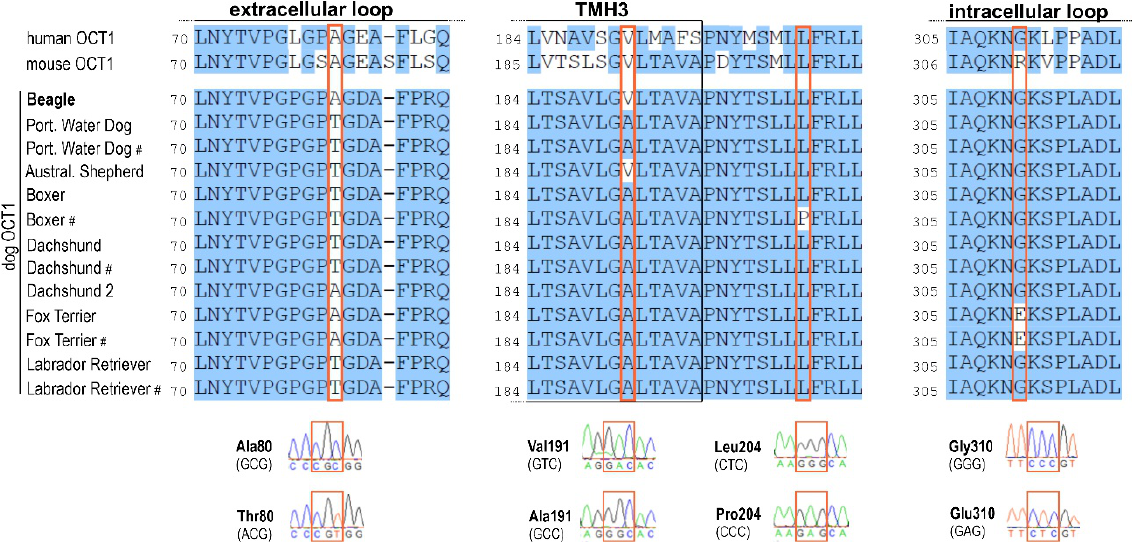
Figure 7. Comparison of OCT1 genetic variability among dogs from different breeds and comparison with human and mouse OCT1s. Dog liver cDNAs from eight individual dogs with seven different breeds were used for re-sequencing of the whole OCT1 open reading frame. Genetic polymorphisms corresponding to amino acid substitutions were found in the large extracellular loop, transmembrane helix 3 (TMH3), and the large intracellular loop. Affected codons are marked in boxes. Exemplary electropherograms depicting the sequence variation are also shown. The experimentally validated reference sequence for the Beagle is highlighted in bold. In five cases, two clones from one breed were sequenced and the second clone is denoted by “#”. For Dachshund, two individual dogs were analyzed.